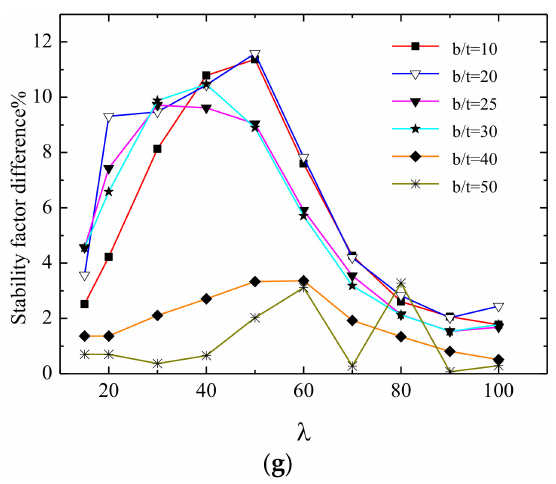
Figure 20. E ff ect of residual stress on the stability factor when the width-thickness ratio is certain. ( a ) b / t = 10, ( b ) b / t = 20, ( c ) b / t = 25, ( d ) b / t = 30, ( e ) b / t = 40, ( f ) b / t = 50, and ( g ) percentage di ff erence of stability factor with or without residual stress.